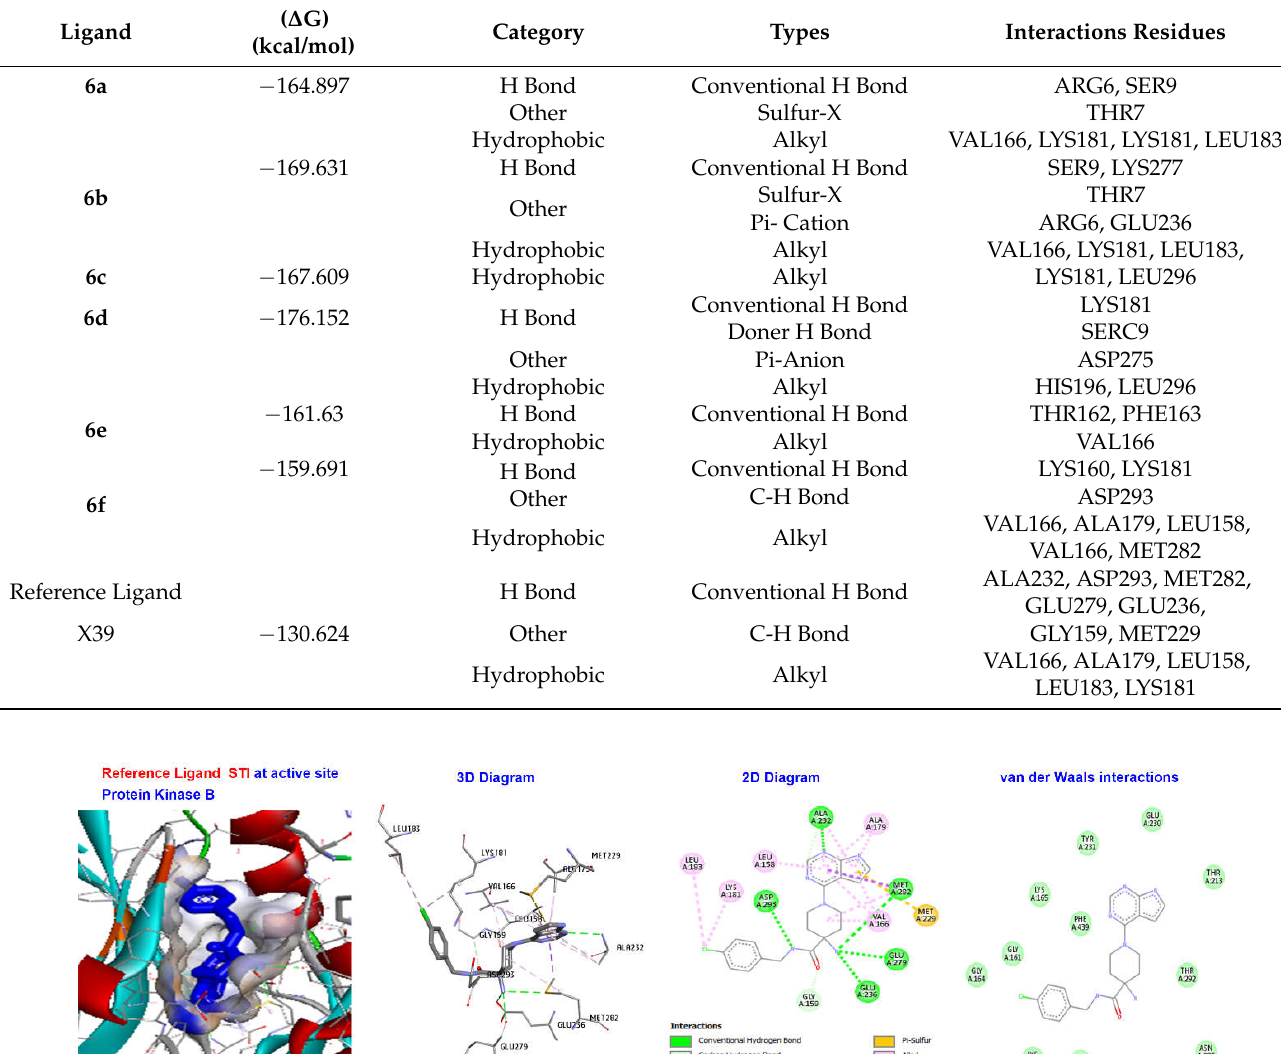
Table 4. Docking of compounds 6a–6f to Protein Kinase B (Akt) binding pocket (PDB ID: 2X39).